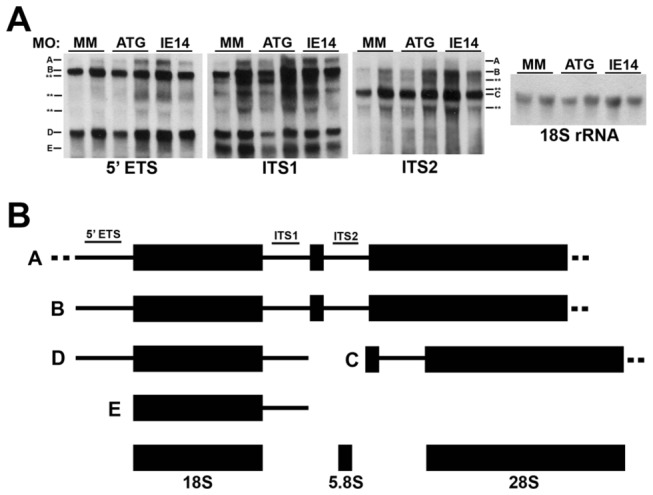
Normal ribosomal RNA processing in Cirhin-deficient larvae.(A) Northern blots demonstrating equivalent levels of pre-rRNA species in duplicate samples of mismatch MO-injected and cirh1a MO-injected embryos. Dashes and letters correspond to presumed pre-rRNA species identified by probes 5’ETS, ITS1, and ITS2, while asterisks indicate unknown pre-rRNA species (schematized in panel B). The far right panel shows the results of blotting with an 18S rRNA probe, demonstrating total RNA loading. Mean 45S/18S rRNA ratios were not statistically different between treatment groups (p>0.05). (B) Schematic depicting presumed pathway of zebrafish ribosomal RNA processing; individual RNA species not drawn to scale (adapted from [32]).